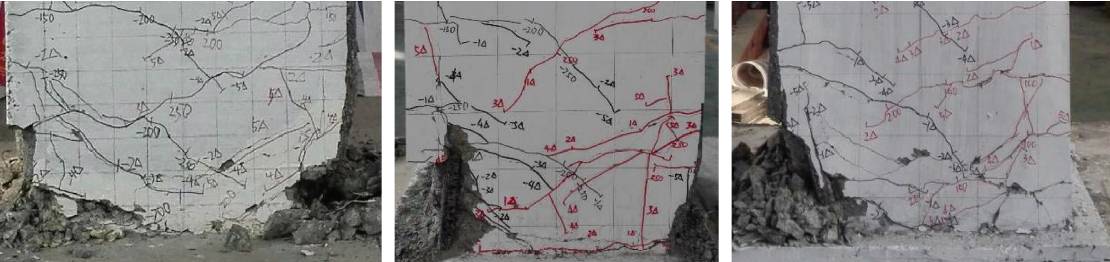
Figure 6: Plastic hinge failure of each specimen.